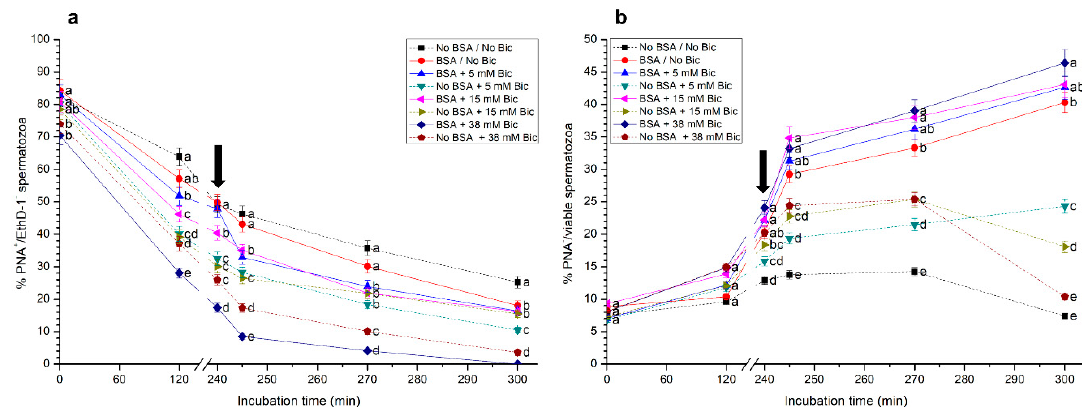
Figure 3. ( a ) Percentages of viable sperm with an intact acrosome (PNA + /EthD-1 − ), and ( b ) percentages of sperm with an exocytosed acrosome considering the viable sperm population only (PNA − /viable sperm) following incubation with different concentrations of bicarbonate (Bic; 0 mM, 5 mM, 15 mM, 38 mM) and BSA (0, 5 mg/mL) for 300 min. The black arrow indicates the time at which 10 µ g/mL of progesterone was added (i.e., 240 min) to induce acrosome exocytosis. Different superscripts (a–e) indicate significant differences ( p <0.05) between treatments within the same time point. Data are shown as mean ± SEM for 12 independent experiments.